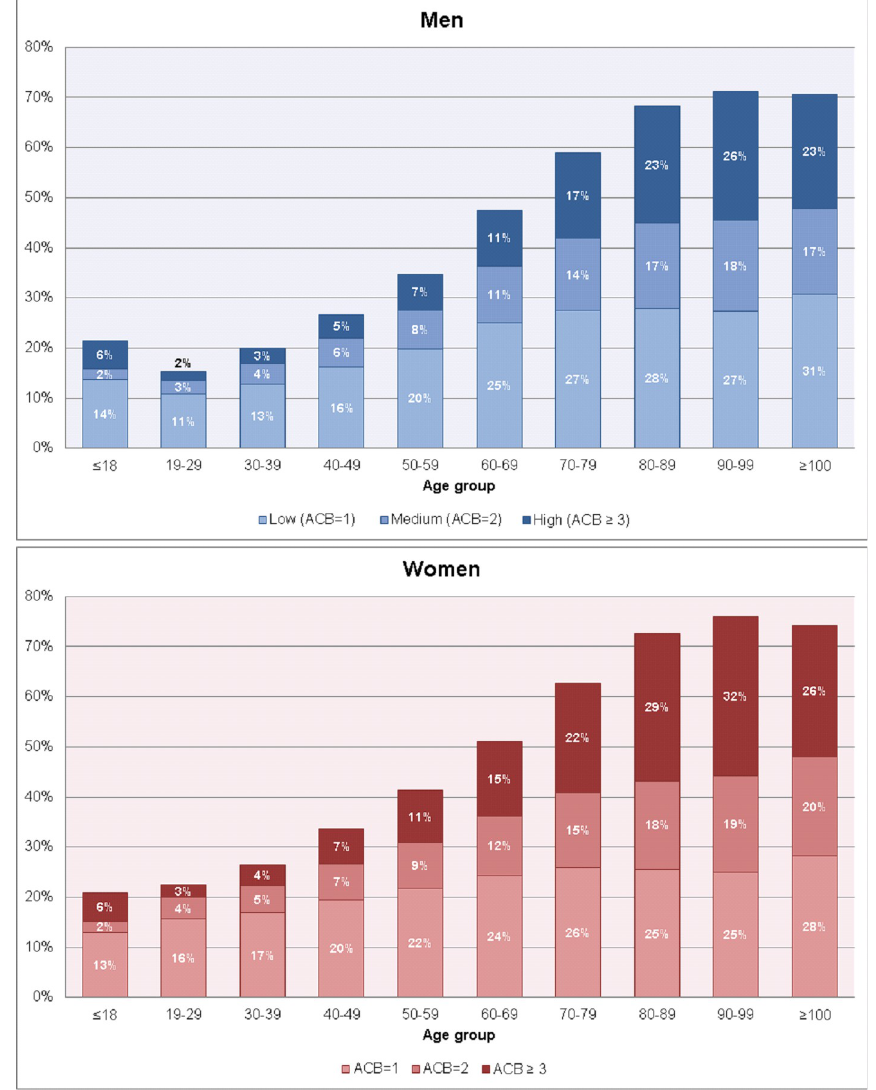
Fig 3. Proportion of anticholinergic burden measured through the Anticholinergic Cognitive Burden (ACB) scale (2016), by sex and age.